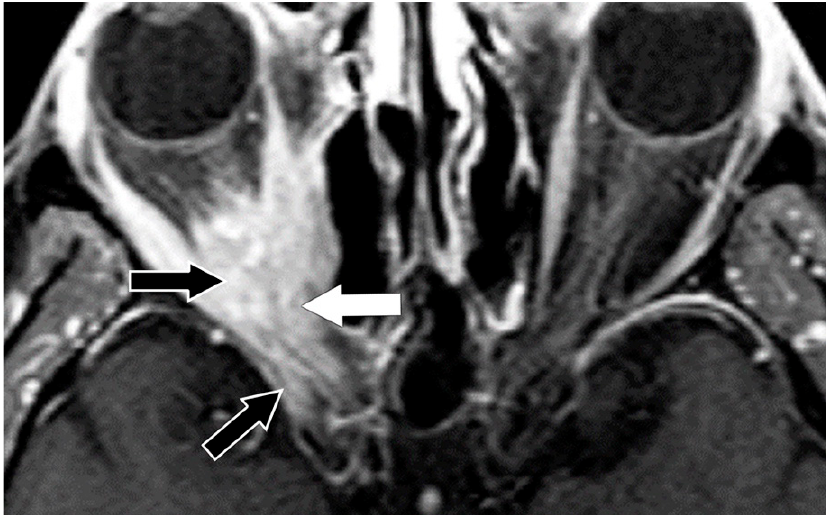
Figure 5. Idiopathic orbital inflammation (IOI). Axial T1 post-contrast MRI sequence shows enlarge- ment of the right medial rectus muscle (white arrow). Additional enhancing disease is present in the right orbit with involvement of the tendinous insertions and extension through the superior orbital fissure towards the cavernous sinus (black arrows).